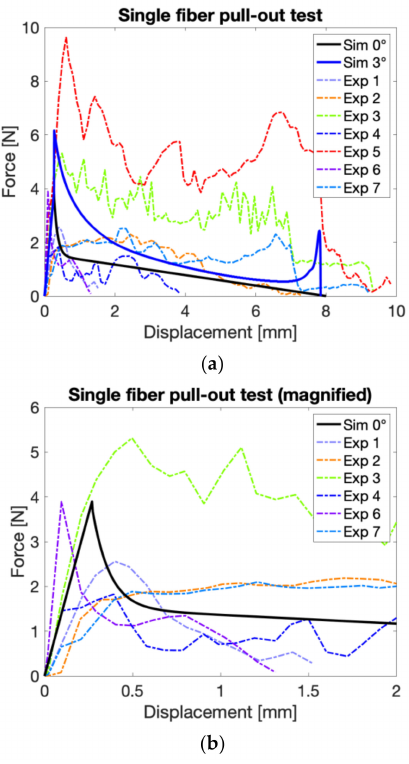
Figure 9. ( a ) Experimentally (dashed lines) and numerically (solid lines) obtained force versus slip curves from pull-out tests of individual fibers from the mortar matrix (0 ◦ indicates that fibers are parallel to the normal to the surface). It can be noticed that in several cases (Exp. 3, 5, 7), a sharp increase in the force is observed near the end of the pull-out experiment. This increase in pull-out could be replicated by the analytical pullout model when a slight inclination (Sim. 3 ◦ ) was introduced. These tests are used to calibrate the bond-slip model (Table 5). ( b ) The magnified view shows the numerical fit to the experimental data on the smaller displacement range. Experiment 5 was not plotted because of the significant deviation in the peak